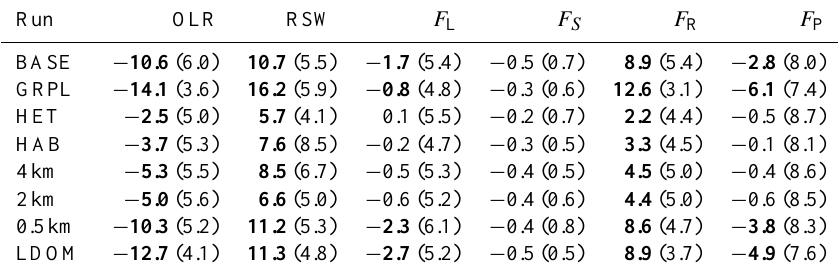
Table 4. Results of ensemble tests described in Table 3. Presented quantities are differences in ensemble means between polluted and pristine conditions (POLL minus PRIS) averaged from 12:00UTC 19 January to 12:00UTC 25 January. Values in parentheses indicate an average of the ensemble standard deviation for the pristine and polluted ensembles. Statistically-significant differences (95% confidence level) are shown in bold. Units areWm − 2